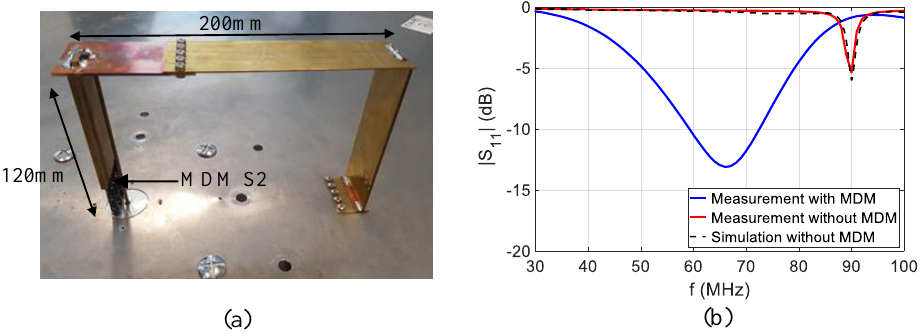
Figure 10. ( a ) Fabricated inverted-F antenna (IFA) antenna loaded with magneto-dielectric material (MDM) S2, ( b ) measurement of the resonance frequency shift with and without MDM.